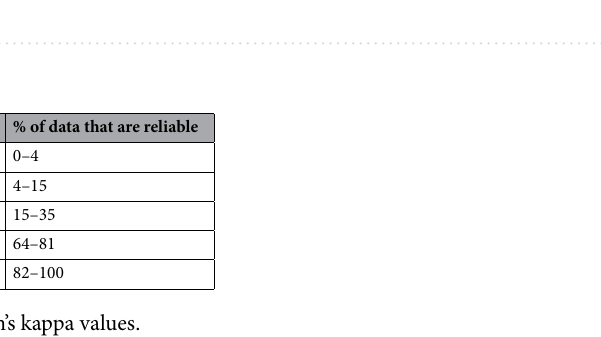
Table 2. Kappa metric results after 30-fold cross-validation. It compares the accuracy of the models to the accuracy of a random system. This statistic is a measure that can handle both multiclass and imbalanced class problems.